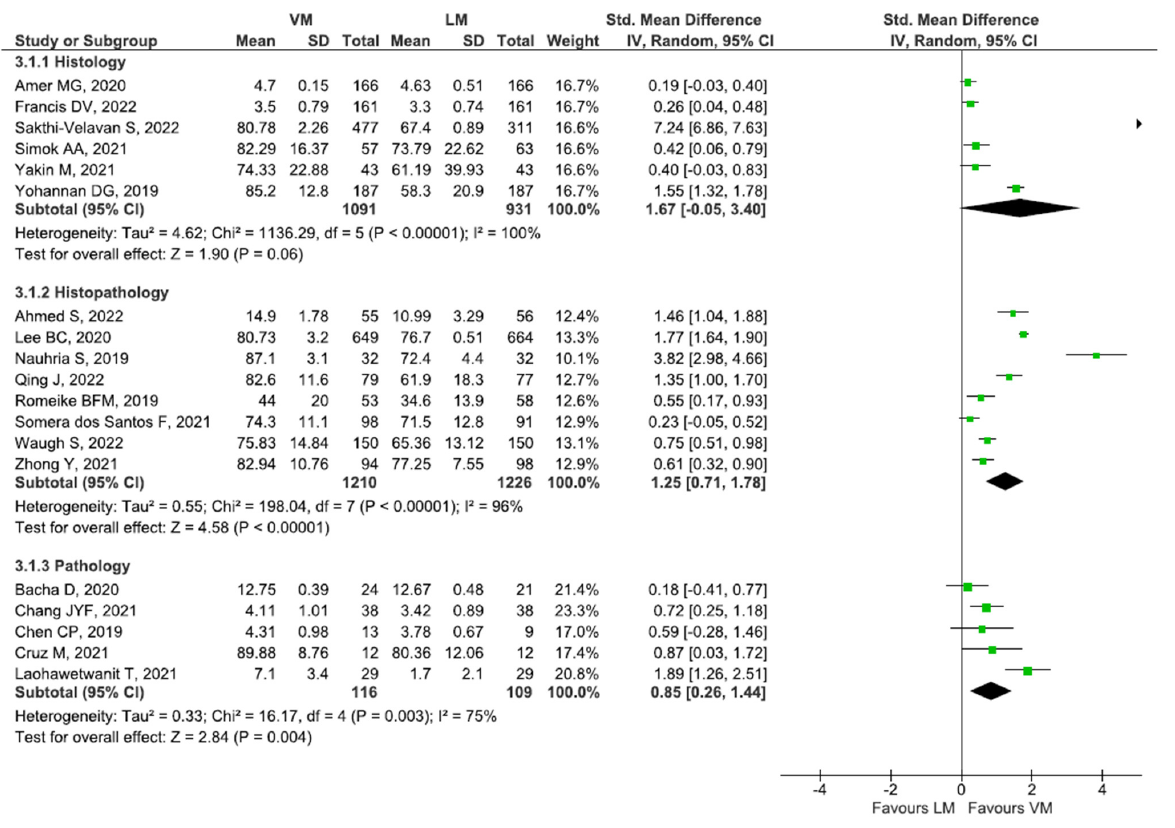
Figure 3. Analysis of studies assessing subject-wise exam performance of students [20,31–35,37–